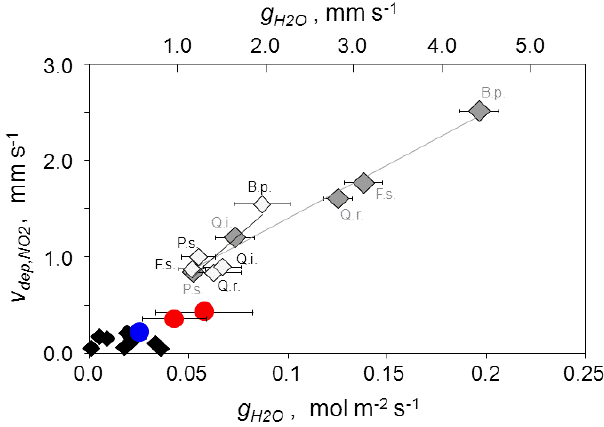
Figure 7. Maximum NO 2 deposition velocities ( v dep,NO2 ) in relation to their corresponding stomatal leaf conductance ( g H2O ) for five tree species ( Betula pendula , Fagus sylvatica , Quercus robur , Quercus ilex , Pinus sylvestris ) at two light intensities (light grey diamonds: PAR = 900 µmol m -2 s -1 ; grey diamonds: PAR = 450 µmol m -2 s -1 ; black diamonds: night time conditions) measured by Chaparro-Suarez et al. (2011), for Picea abies measured in the present study (red filled circle), and for Picea abies measured under laboratory conditions (blue filled circle; data see Breuninger et al., 2012).